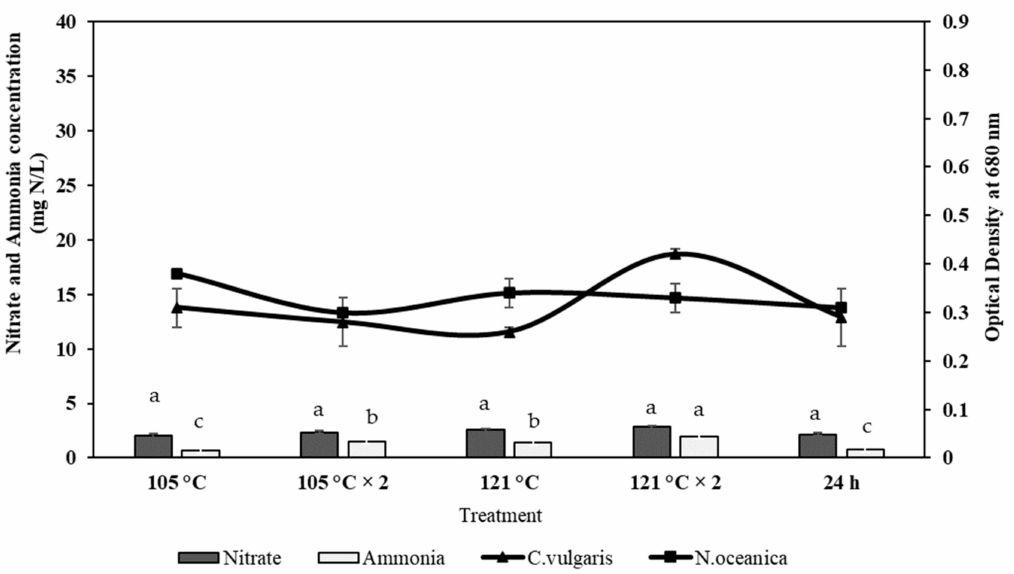
Figure 5. Effect of ammonia and nitrate concentration in on the growth of C. vulgaris and N. oceanica from Ayer Hitam Forest Reserve (AHFR) with different extraction methods. (105 ◦ C—autoclave 105 ◦ C; 105 ◦ C × 2—autoclave 105 ◦ C × 2 after natural extraction 24 h; 121 ◦ C—autoclave 121 ◦ C after natural extraction 24 h; 121 ◦ C × 2—autoclave 121 ◦ C twice after natural extraction 24 h; 24 h—natural extraction for 24 h). Error bars represent standard deviation ( n = 3). a–c Mean value with different superscripts are significant different ( p < 0.05) using ANOVA and Turkey